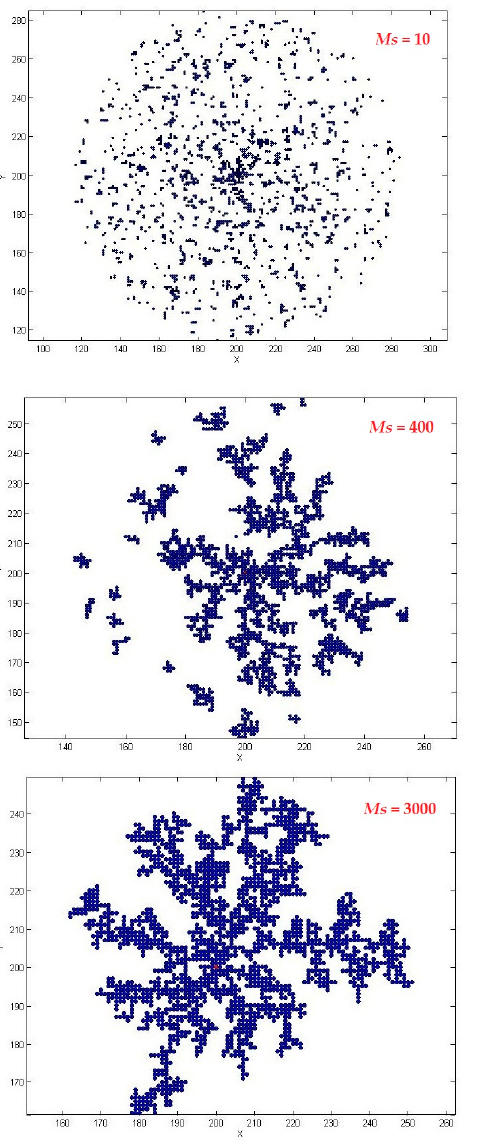
Figure 10. Effect of launch radius on the fractal dimension and porosity of 2D and 3D DLA aggregates.